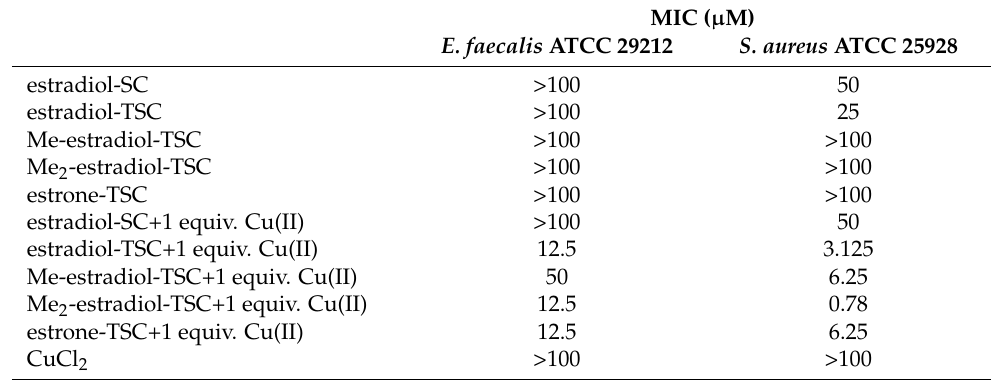
Table 6. MIC values determined for the ligands in the absence and presence of 1 equiv. Cu(II) on Gram-positive bacteria strains. MIC ( µ M) E. faecalis ATCC 29212 S. aureus ATCC 25928 estradiol-SC >100 50 estradiol-TSC >100 25